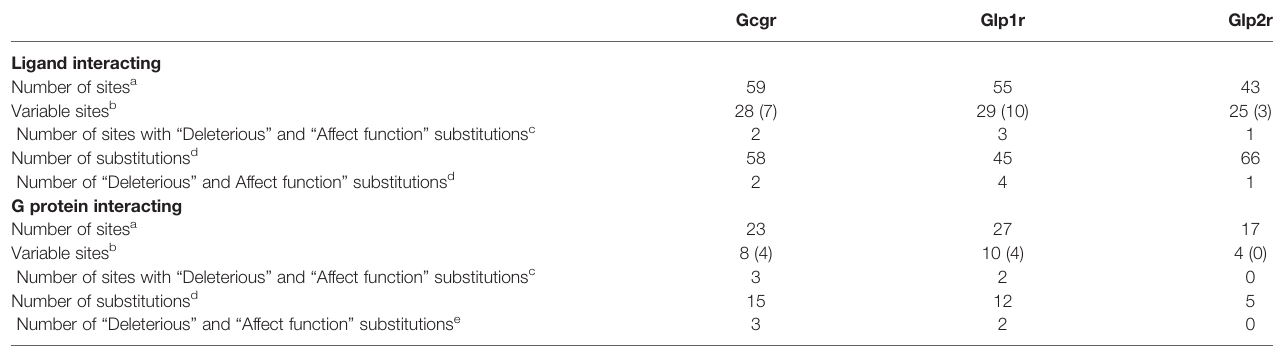
TABLE 4 | Variability in ligand and G protein interacting sites in Gcgr, Glp1r, and Glp2r.